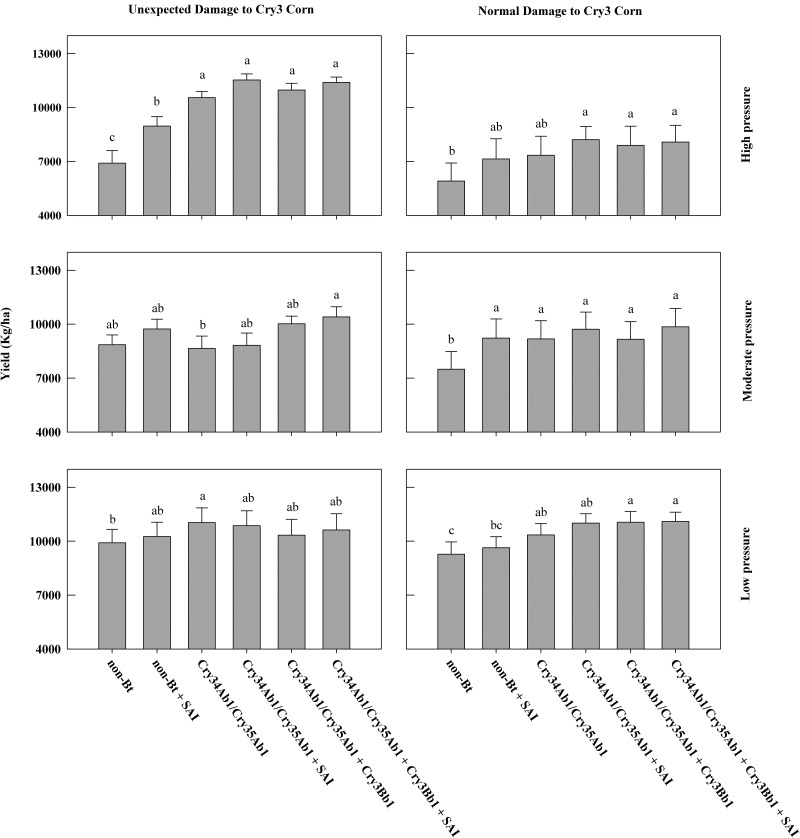
Mean grain yield (kg/ha) ± standard error of corn hybrids with or without soil-applied insecticide (SAI), presented by level of corn rootworm injury to Cry3-expressing corn (normal or unexpected) and under high (>2 NIS), moderate (1–2 NIS), or low (<1 NIS) root feeding pressure. Yield with the same letter do not differ significantly (LSD, α = 0.05).